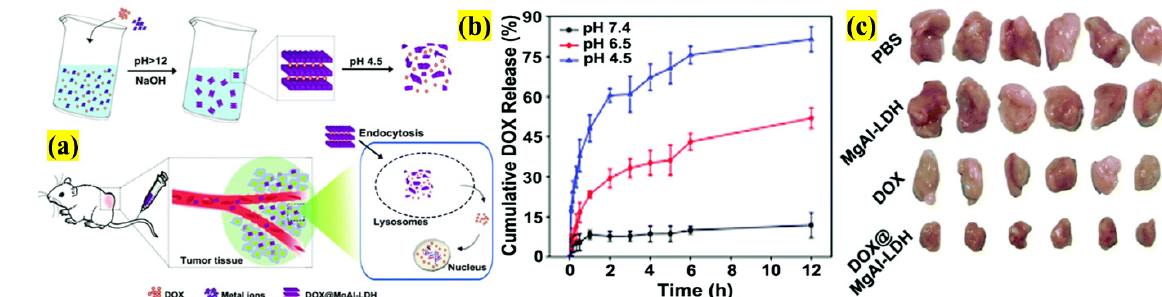
Figure 11. Schematic illustration of ( a ) the synthesis process of DOX-functionalized LDHs and employing them as nanocargo; ( b ) pH-based DOX release at 37 °C; ( c ) size comparison photographs of tumors obtained after treatment (adapted with permission from Reference [71] Journal of Materials Chemistry B, published by The Royal Society of Chemistry, 2018).